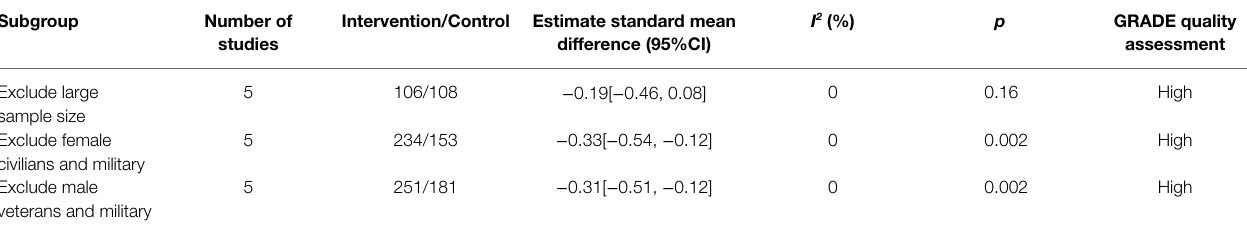
TABLE 4 | Summary of sensitivity analysis on sample size, gender and culture.